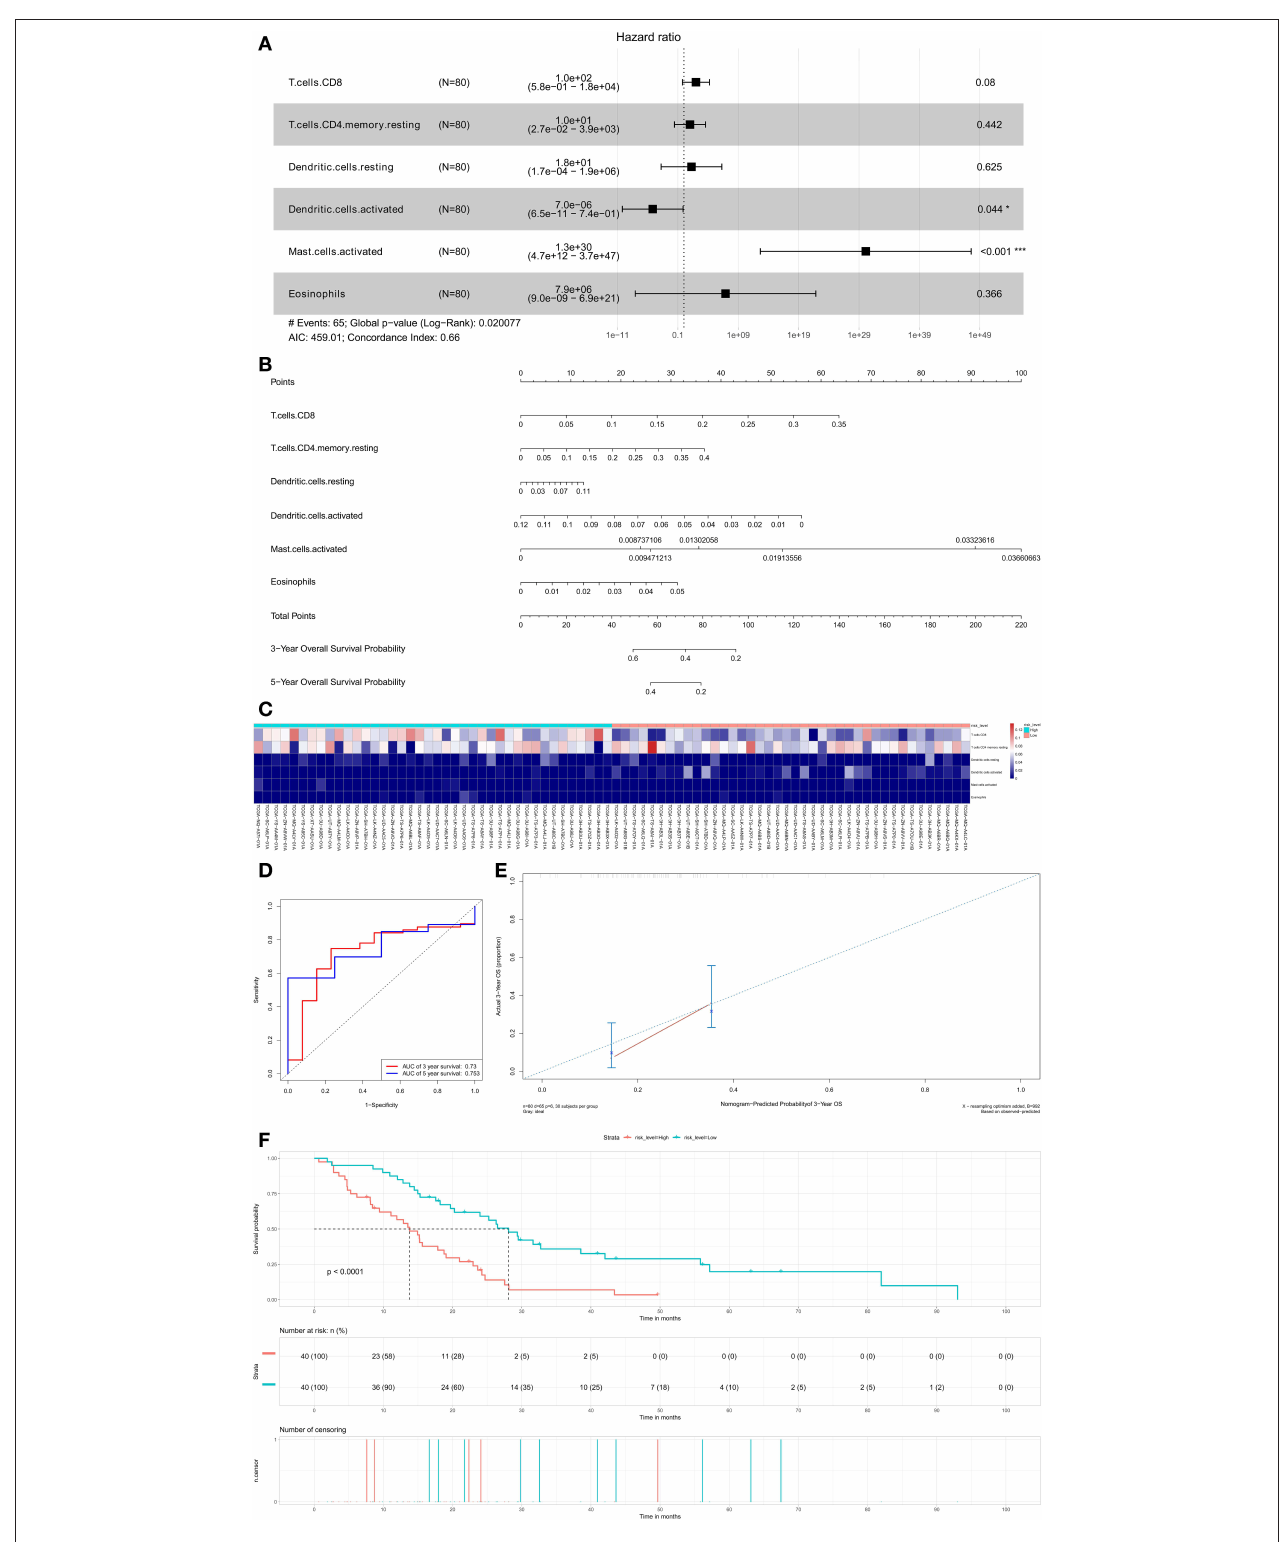
FIGURE 7 | The results of the multivariate Cox regression (A) based on prognosis-related immune cells nomogram (B) ; the ROC curves (C) ; the heatmap of the six immune cells in Cox regression model (D) ; Nomogram-Predicted probabilitu of 3-year overall survival (E) ; the Kaplan–Meier survival curve (F) .